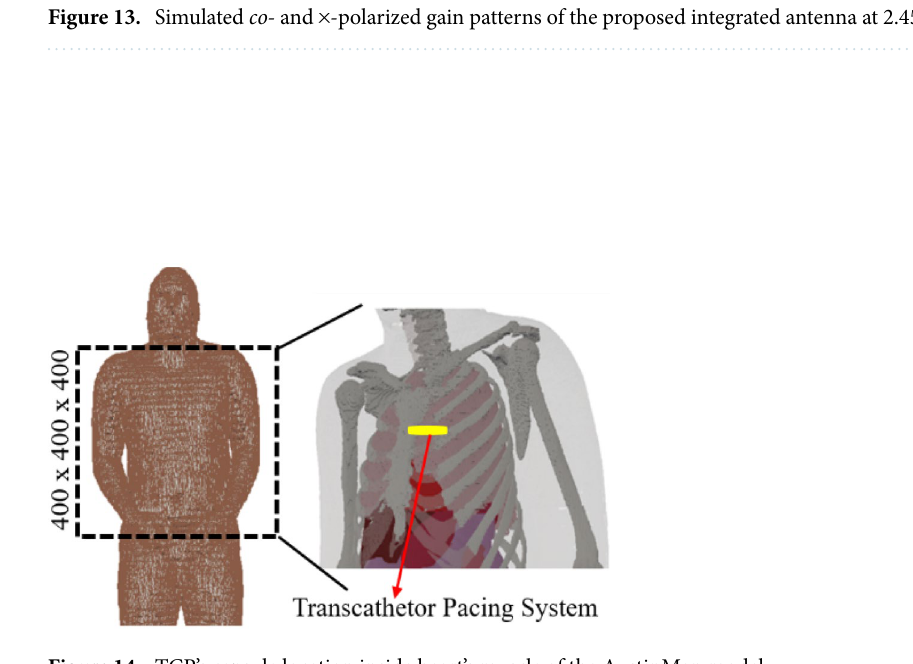
Figure 14. TCP’s capsule location inside heart’s muscle of the AustinMan